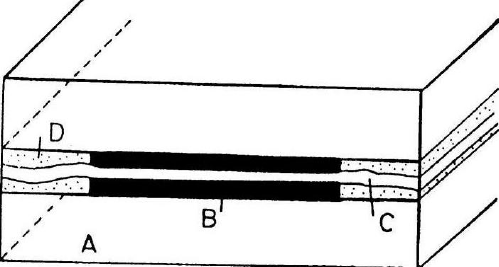
Figure 6. Double microband electrode: A — Glass, B — metal foil, C — spacer, D — epoxy